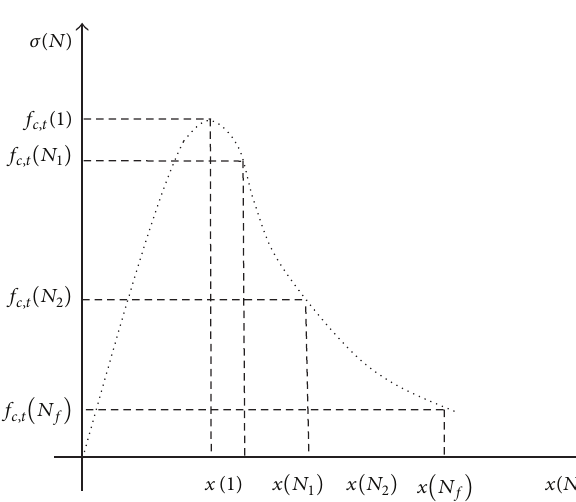
Figure 4: Residual strength envelope of concrete under cyclic load- ing.